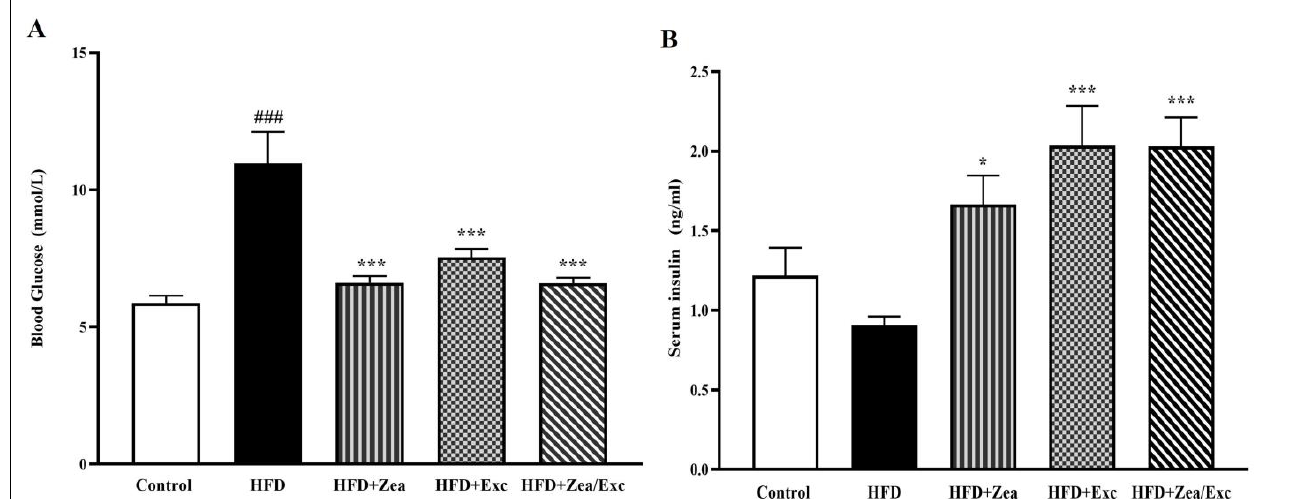
Figure 3. Effects of Zea and Exc on blood glucose levels ( A ) and insulin levels ( B ) in HFD-induced obese rats. Data are expressed as means ± SEM, n = 7. ### p < 0.001 vs. control; * p < 0.05, *** p < 0.001 vs. HFD.